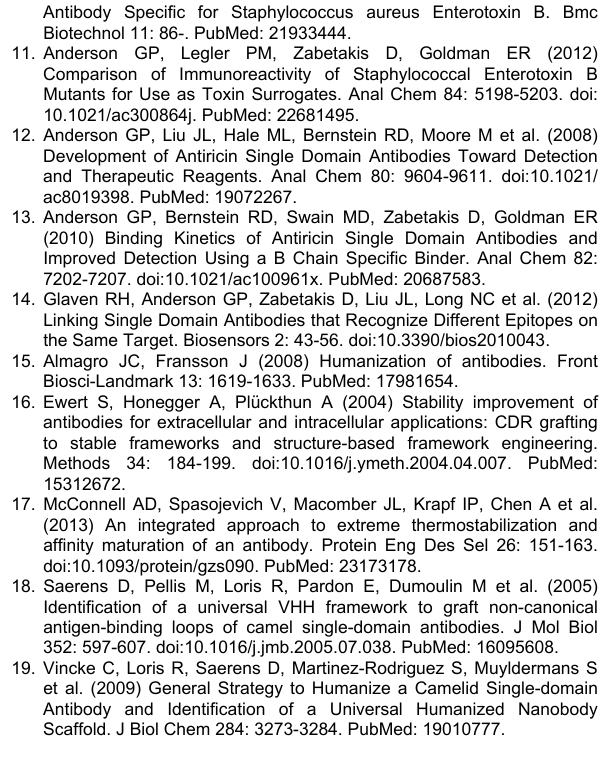
Figure S1. Circular dichroism measurements of melting temperature of antibody constructs presented in this paper. Heating and cooling curves are shown for each mutant. (DOC) Figure S2. Surface plasmon resonance measurements for affinity of the constructs presented in this paper. The target was SEB for all antibodies except A3D1 and A3C8, for which the target was ricin.